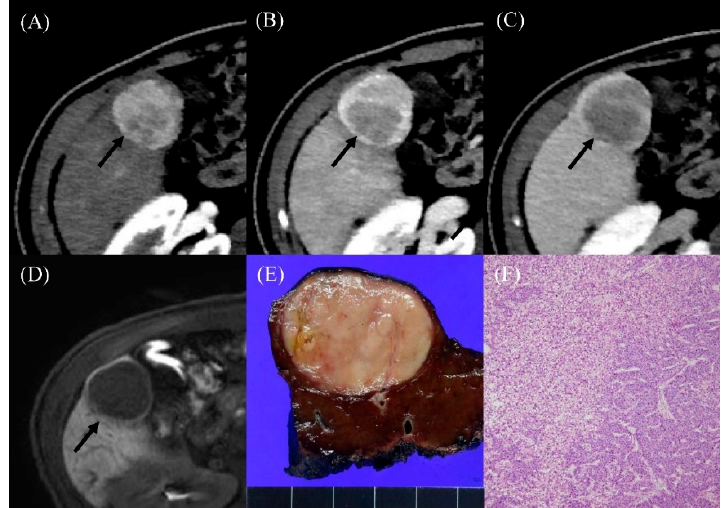
Figure 2. Radiologic findings in a 36-year-old male who developed hepatocellular carcinoma 15 years after the Fontan operation. ( A ) Contrast-enhanced arterial-phase axial CT image shows a 4-cm-sized enhancing mass in segment V of the liver (arrow). ( B ) The posterior portion of mass shows washout in the portal venous phase axial CT image (arrow). ( C ) The washout of the mass was more evident on the delayed phase image (arrow). ( D ) On hepatobiliary phase of gadoxetic-acid-enhanced liver MR, the mass shows low signal intensity (arrow). The serum AFP level was elevated to 274.4 ng/mL. ( E ) The resected specimen revealed a well-circumscribed, solid, pinkish mass. ( F ) Histological examination showed well-differentiated hepatocellular carcinoma with a trabecular pattern (H and E, × 40). Figure 3. Imaging findings in a 22-year-old male who developed a benign arterial-phase enhancing nodule 18 years after the Fontan operation. ( A ) The contrast-enhanced arterial-phase axial CT image shows a 3-cm-sized enhancing mass in segment VII of the liver (arrow). ( B ) This mass exhibits the appearance of washout in the delayed phase image (arrow). ( C ) The gadoxetic-acid-enhanced arterial- phase axial MR image obtained 1 month after the CT scan also shows a 3-cm-sized enhancing mass in segment VII of the liver. ( D ) This mass has high signal intensity in the transitional phase image (arrow). ( E ) In the hepatobiliary phase image, this mass has high signal intensity (arrow), suggesting the presence of functioning hepatocytes. The serum AFP level was 4.7 ng/mL in this patient. ( F ) In the